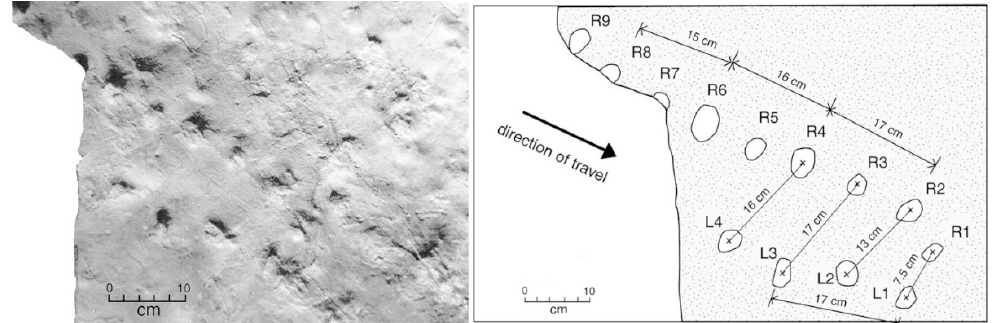
Figure 7. Chuckanut Formation turtle trackway and drawing showing travel direction and dimensions.